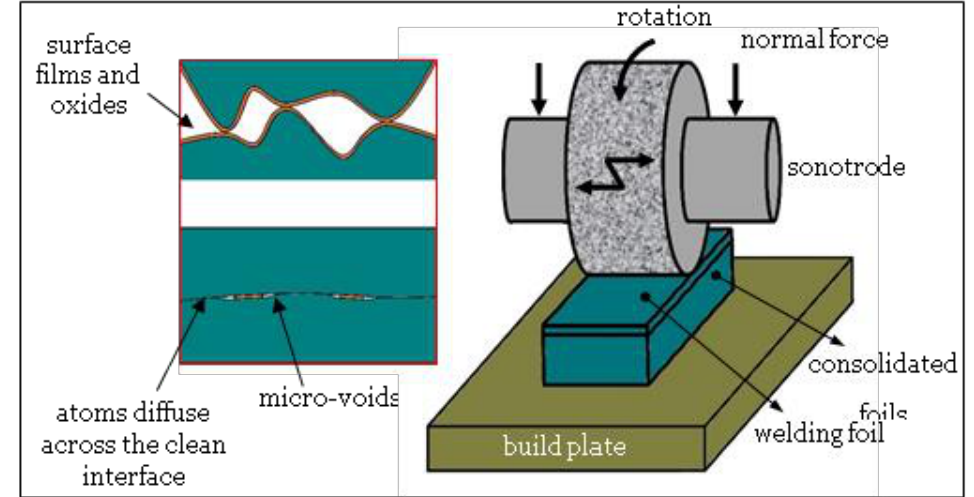
Figure 8. Schematic view of UAM process.